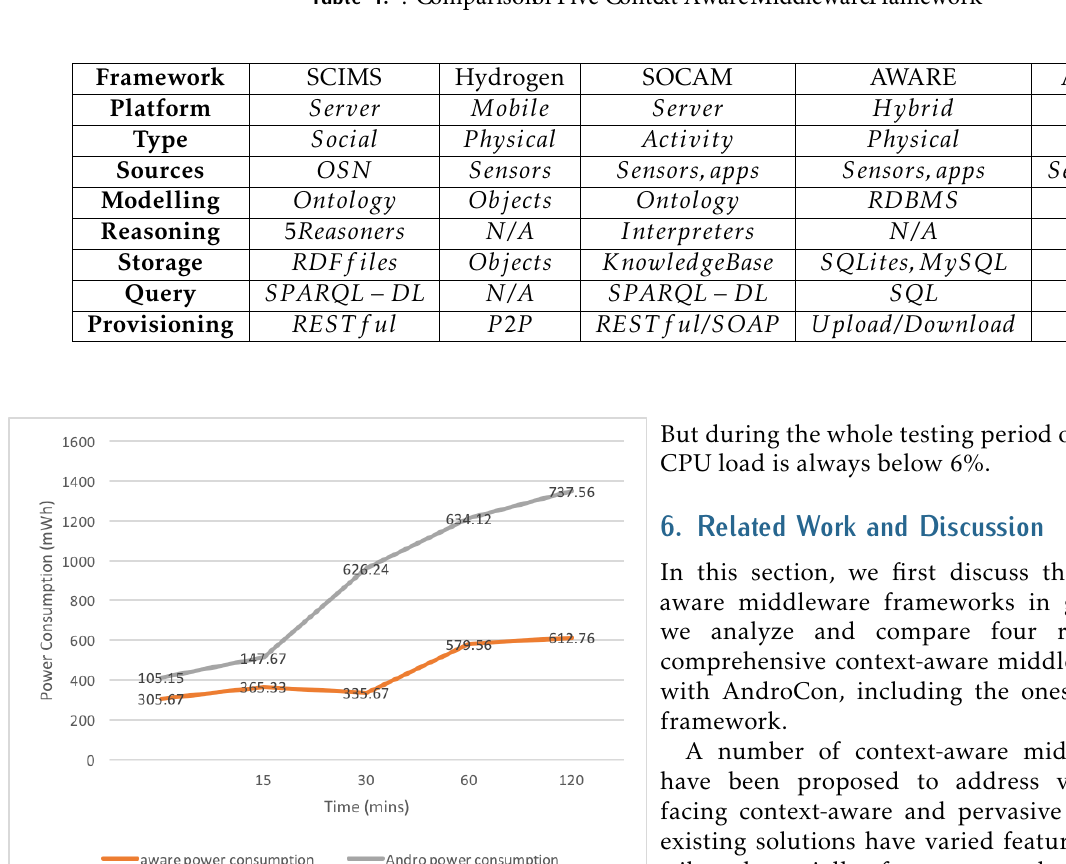
maximum potential of the CPU. As shown in the figure, the application started to use about 4.5% of CPU loads during the testing period of the first 15 minutes and later decreases as the time increases up to 60 mintues, and then there is an increase from 60 to 180 minutes.